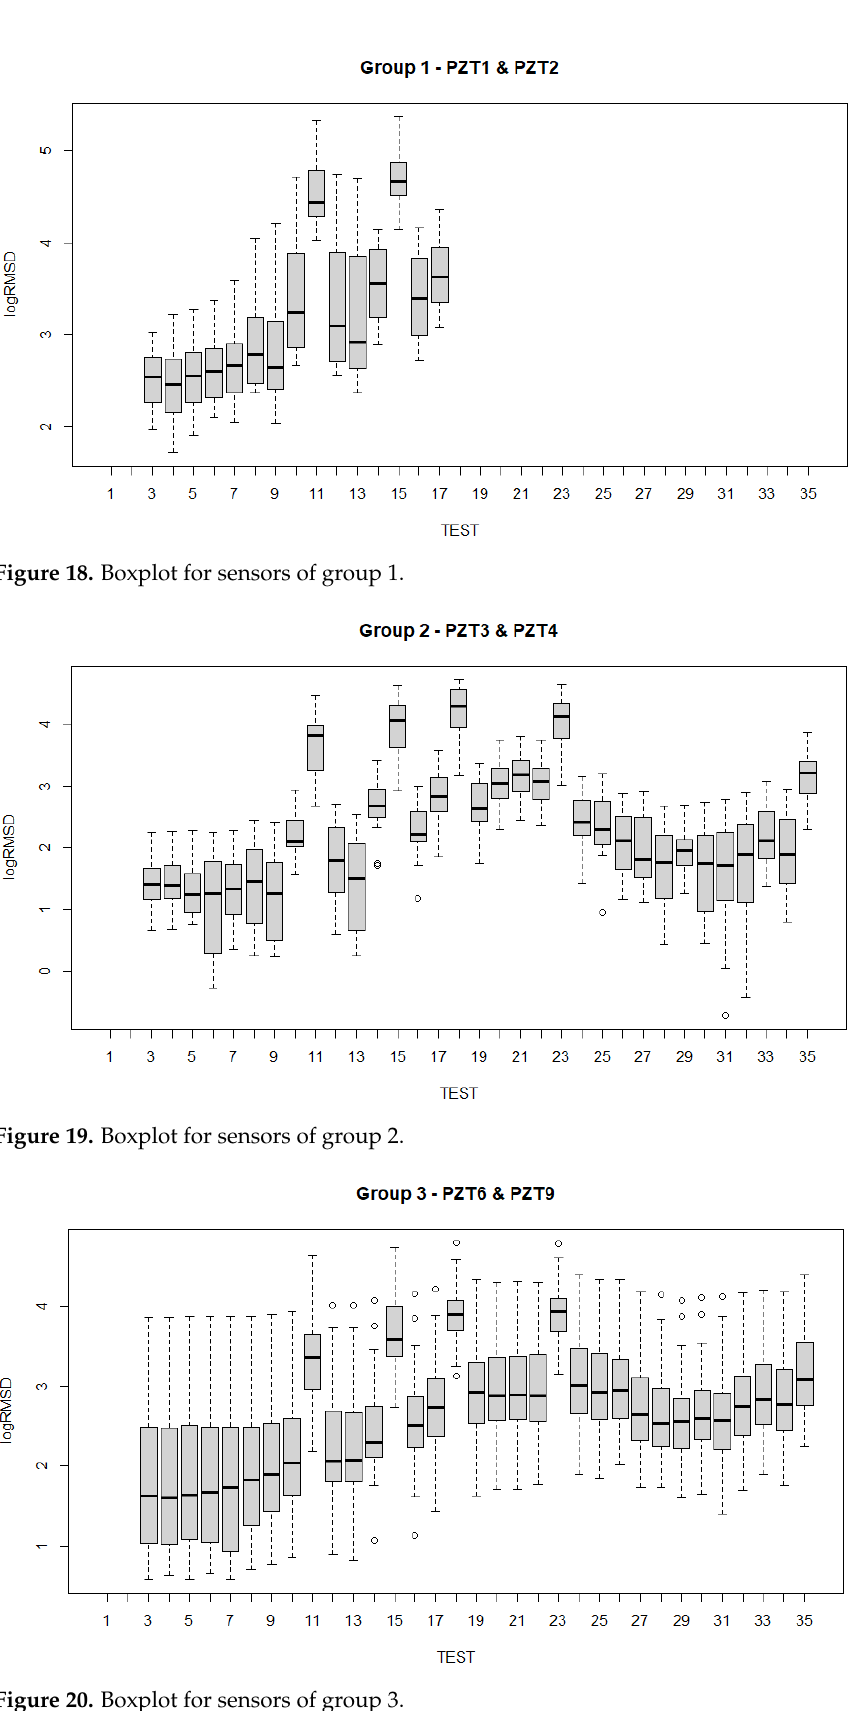
Figure 17. Boxplot for all sensors.